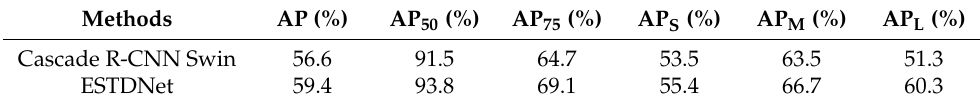
Table 2. The experimental result of ESTDNet on the SSDD